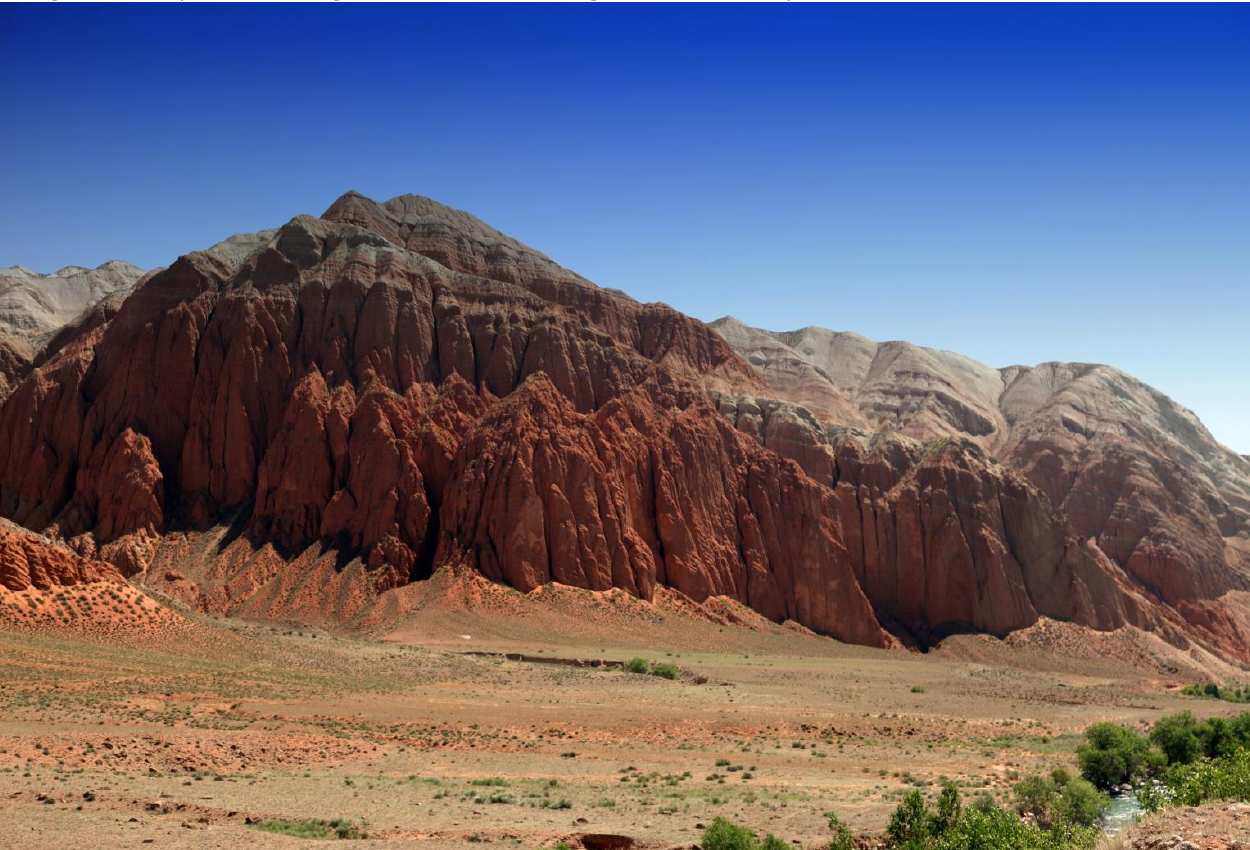
Fig. 5. Central part of Dzhumgaltoo Mts. near Aral, huge screes are biotopes of Paralasa kusnezovi (Avinov, 1910).